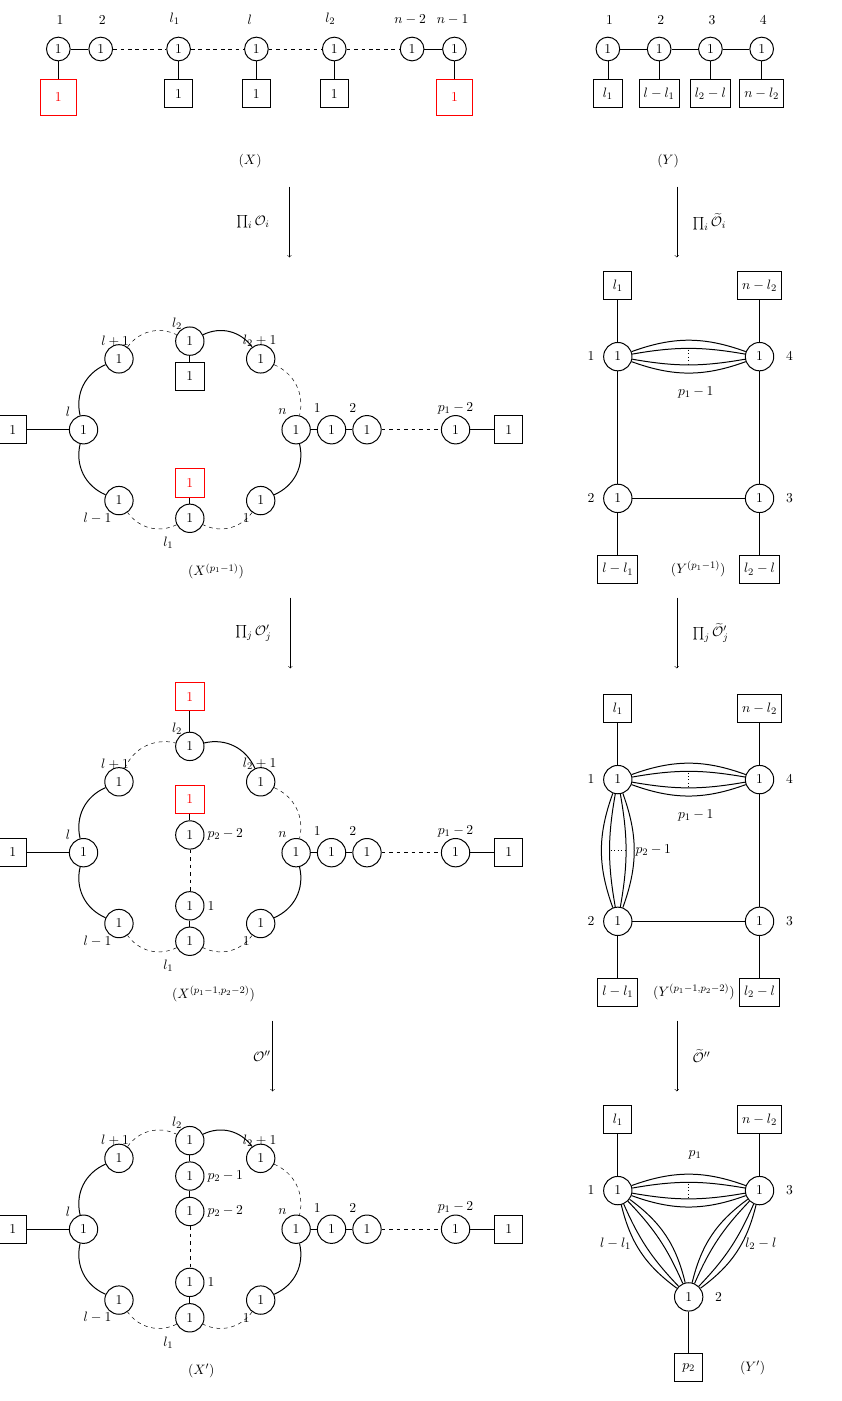
Figure 22 . The quiver ( X 0 ) and its mirror dual ( Y 0 ) in figure 20 is generated by a sequence of elementary S -type operations on different nodes. In each step, the flavor node(s) on which the S -type operation acts is shown in